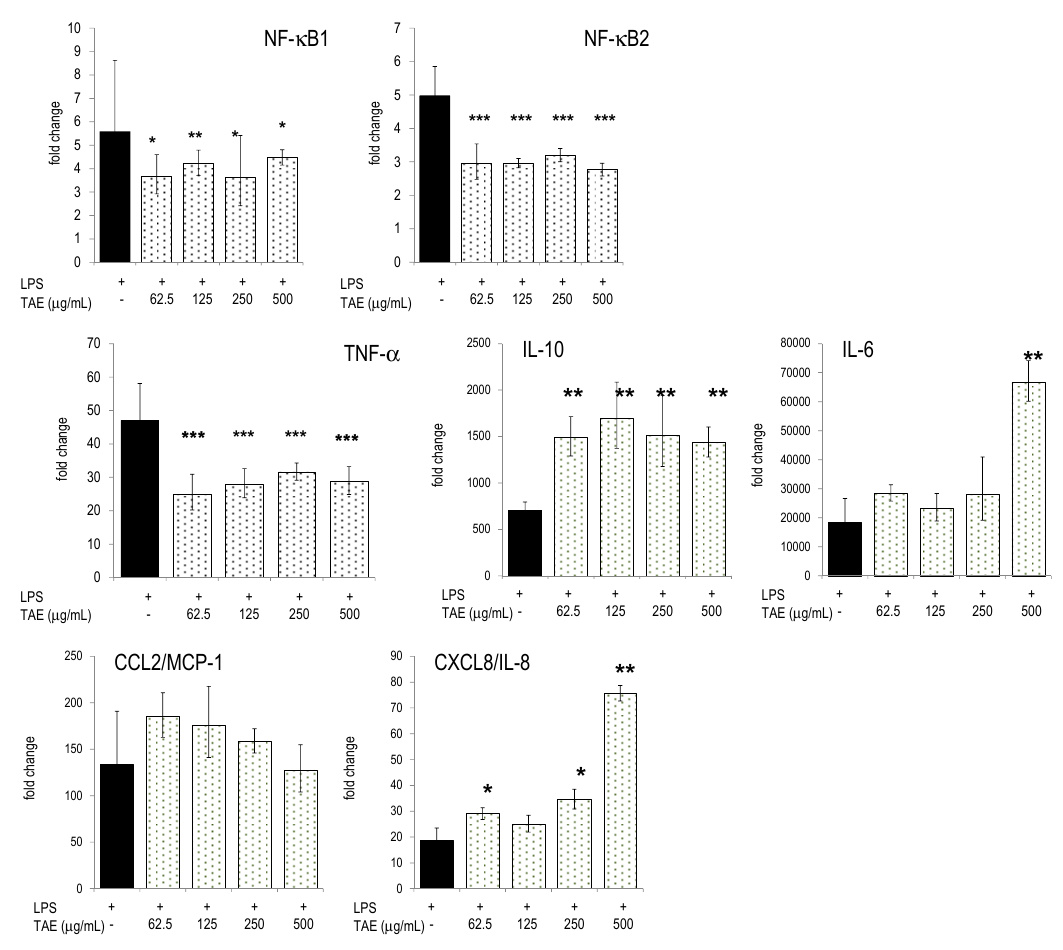
Figure 4. Gene expression in human PBLs and TAE-induced expression changes. Freshly isolated PBLs were incubated with TAE, stimulated with LPS and cultured for 12 h. Gene expression was quantified by RT-PCR and the data expressed as fold change compared to levels observed in unstimulated cells. Mean ± SD of duplicates are given. Representative data of one of three tested donors are shown. * p < 0.05, ** p < 0.01, *** p < 0.001 ( vs. LPS-stimulated cells).